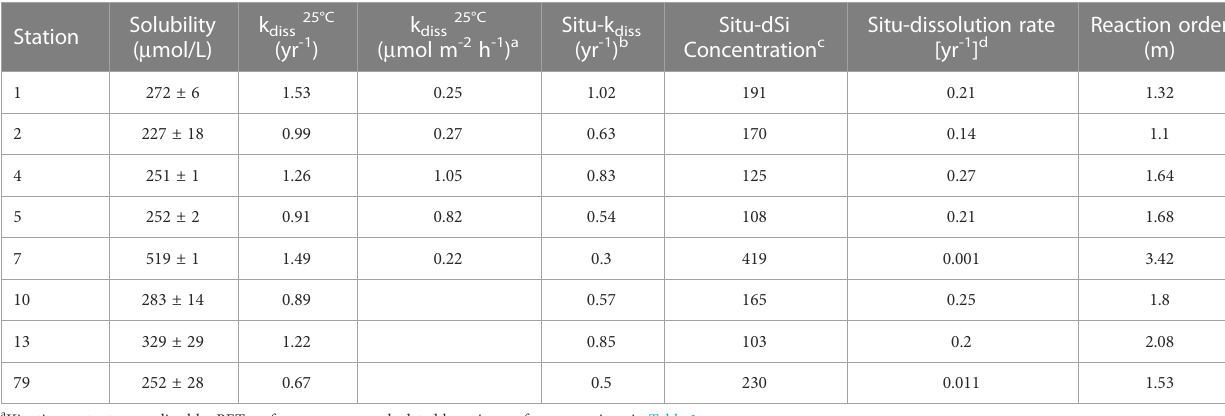
TABLE 2 Flow-through experimental